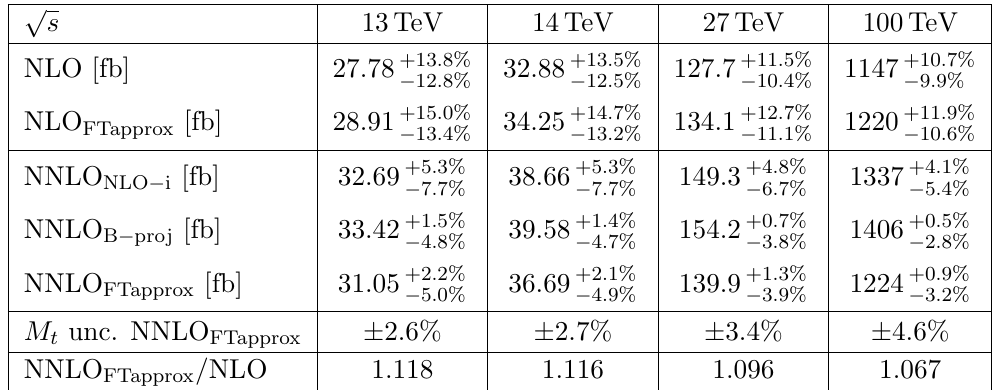
Table 1 . Inclusive cross sections for Higgs boson pair production for di(cid:11)erent centre-of-mass en- ergies at NLO and NNLO within the three considered approximations. Scale uncertainties are reported as superscript/subscript. The estimated top quark mass uncertainty of the NNLO FTapprox predictions is also presented. The uncertainties due to the q T -subtraction and the numerical eval- uation of the virtual NLO contribution are both at the per mille